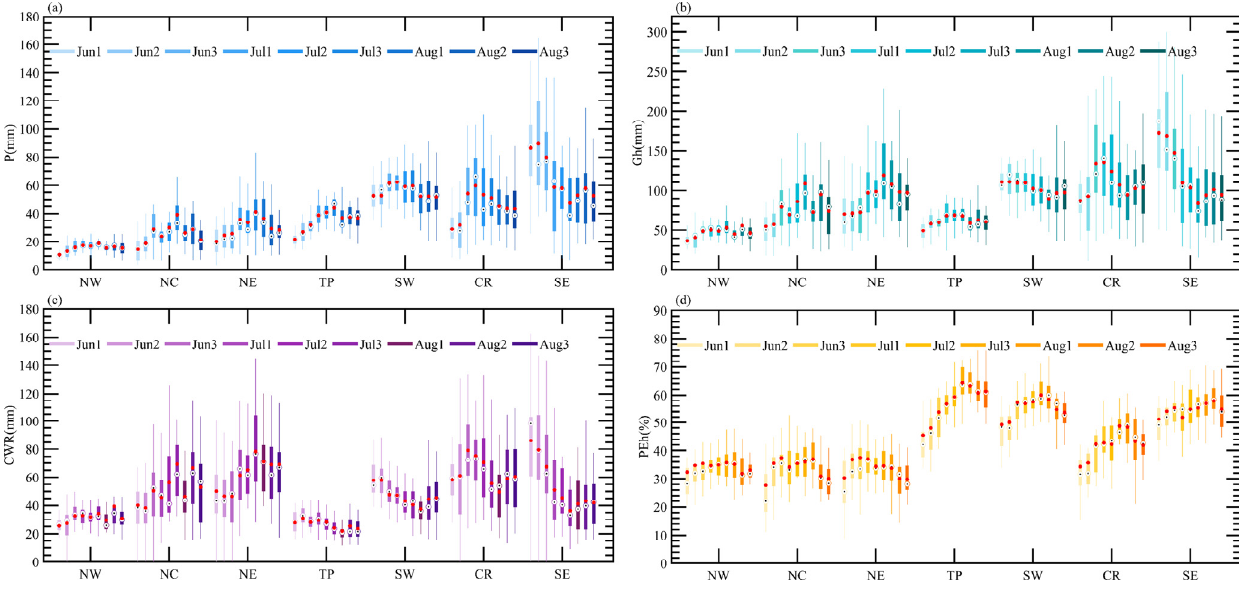
Figure 12. Box plot of summer ten-day variations of ( a ) P, ( b ) Gh, ( c ) CWR, and ( d ) PEh in the seven sub-regions of China during the summers of 2001–2020. The black dots in the boxes represent the median (Q3); the upper and lower sides of the boxes represent the upper quartile (Q4) and lower quartile (Q2), respectively; the upper and lower ends of the boxes’ lines represent 1.5 times greater than the interquartile range (IQR = Q4–Q2) of the Q4 and 1.5 times less than the IQR of the Q2, representing outliers; and the red dots in the boxes represent the mean values. 1, 2, and 3 represent the early, middle, and last ten days of a month, respectively.